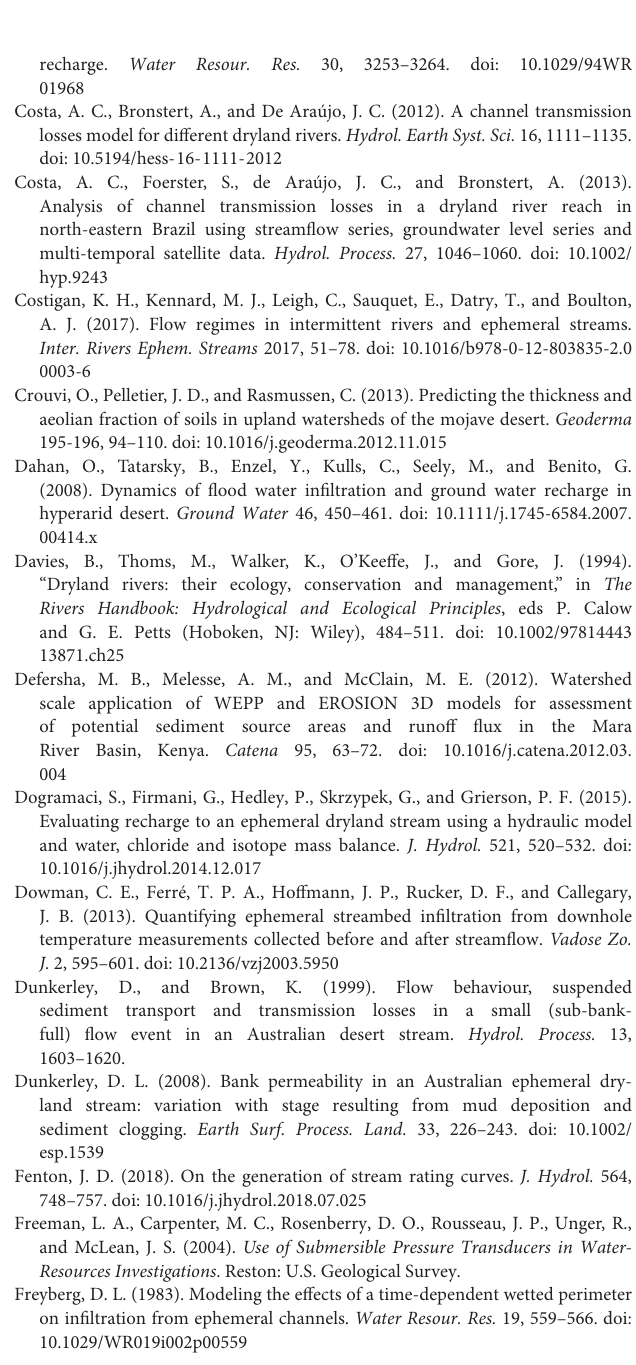
FIGURE S1 | Frequency duration curve for the daily water level measured between July, 2013 and January, 2016 at the existing Gauge